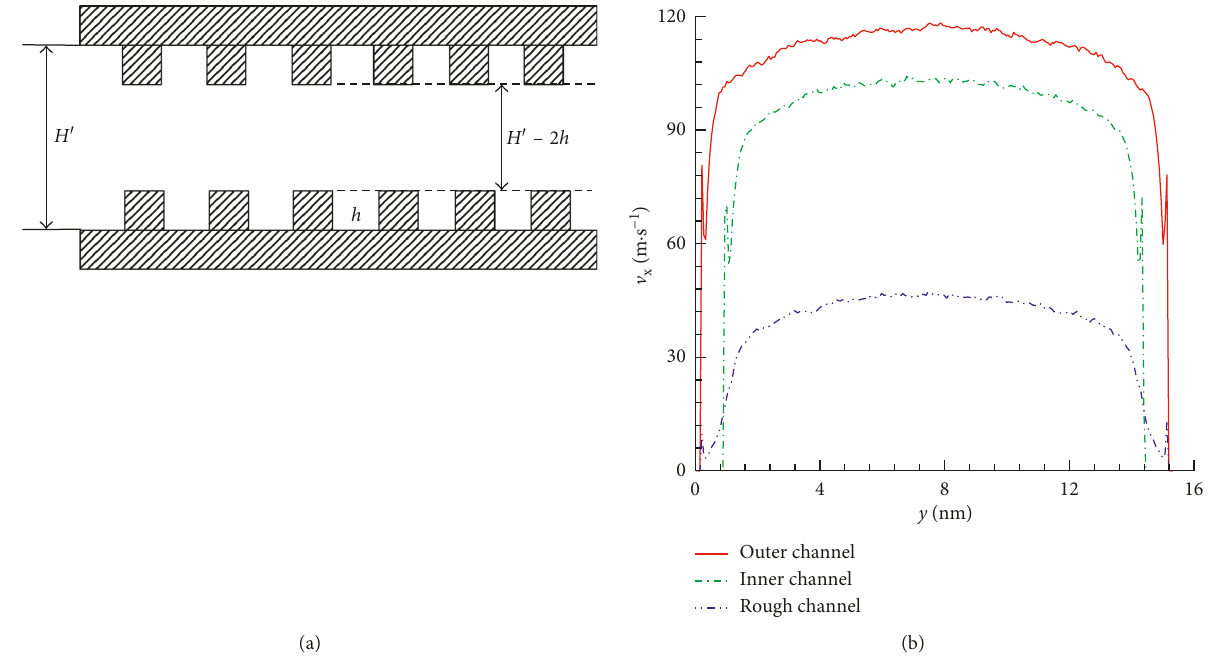
Figure 4: Comparison of gas flows in nanoscale smooth and rough